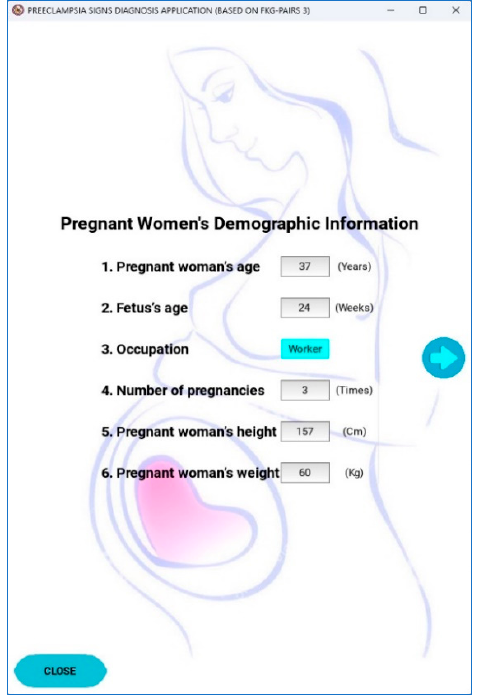
Figure 6. Screen for entering demographic information.